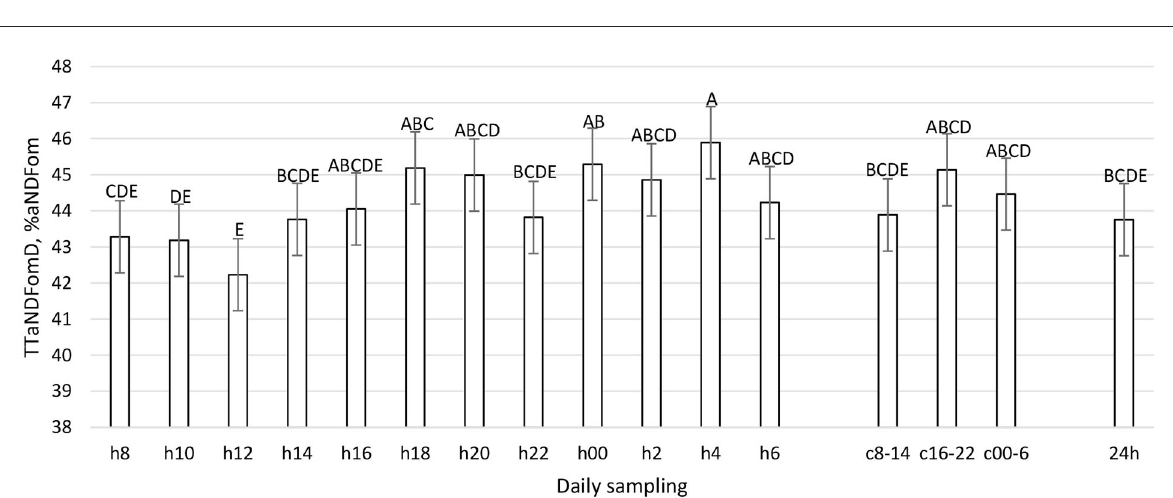
during which the cow spent more time eating (Figures 2,